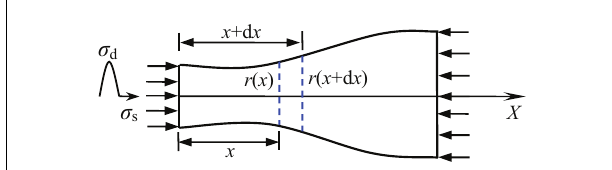
FIGURE 1 | Sketch map of a pre-stressed rod with variable cross-section under coupling static-dynamic loads.